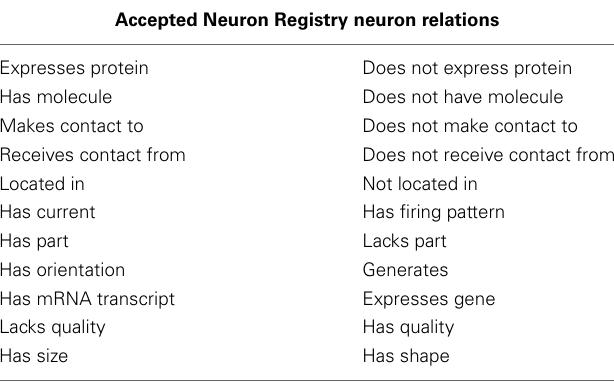
Table 2 | The list of accepted Neuron Registry neuron relation values used for creating the annotated document